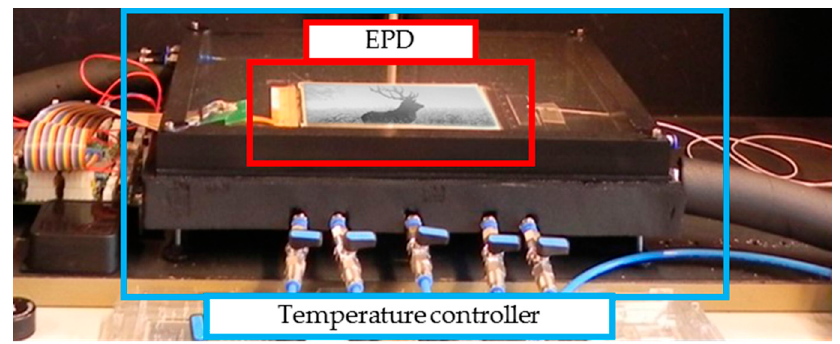
Figure 9. The details of the EPD and the temperature controller. Temperature controller was Julabo FP25-ME.